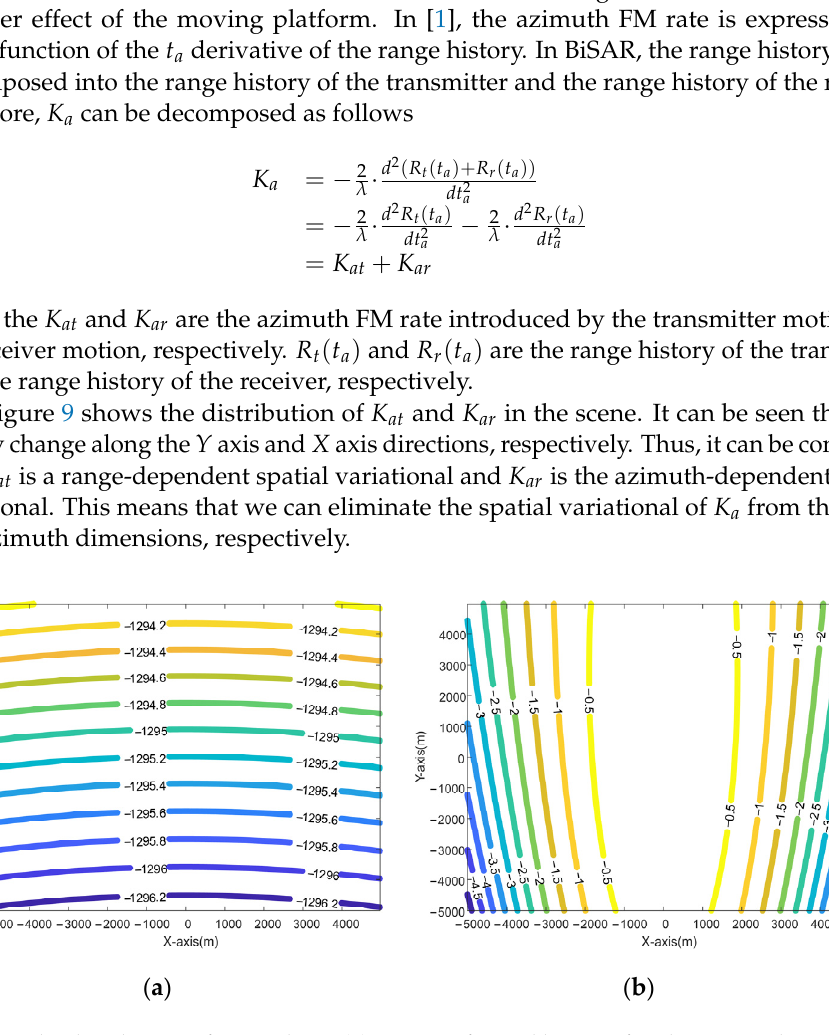
Figure 8. The distribution of K a and K t . ( a ) Value of K a ; and ( b ) Value of K t .